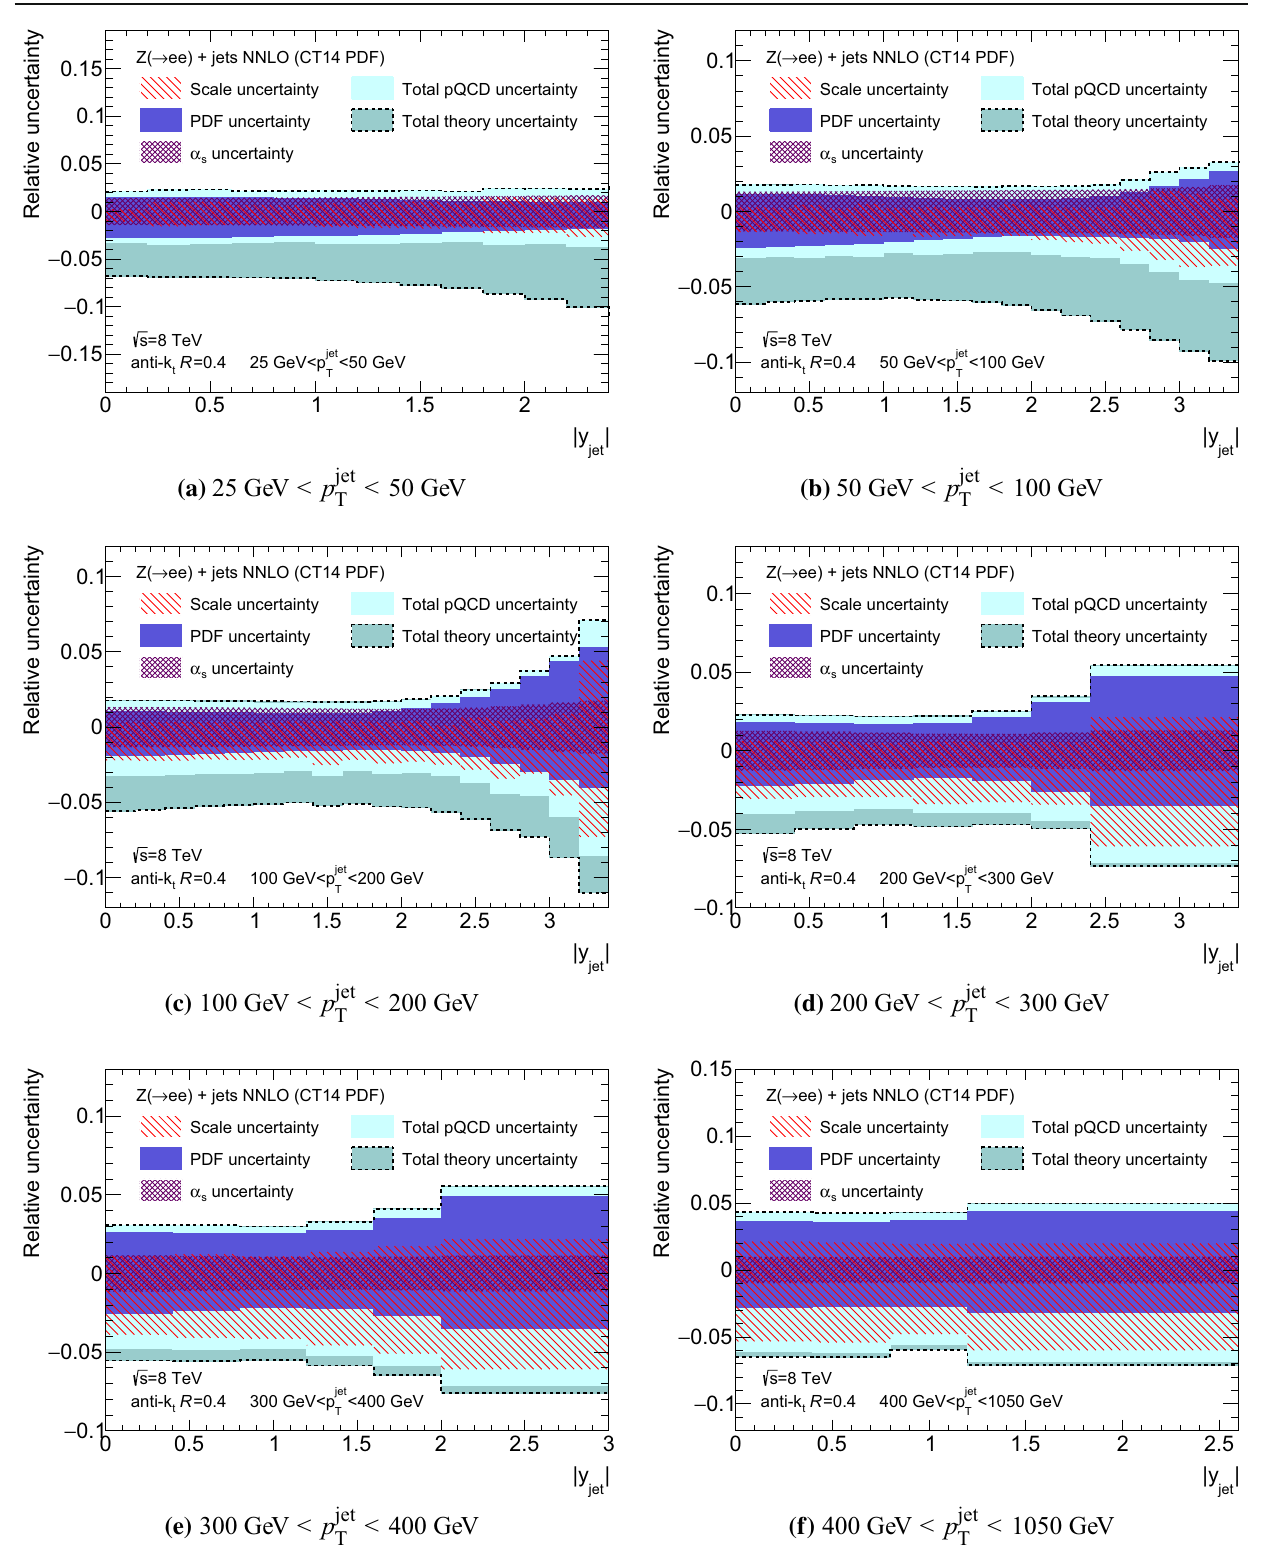
Fig. 6 The uncertainties in NNLO pQCD predictions as a function of | y | in p jet bins. Total pQCD uncertainty is the sum in quadrature of jet T the PDF, scale and α S uncertainties. Total theory uncertainty is the sum